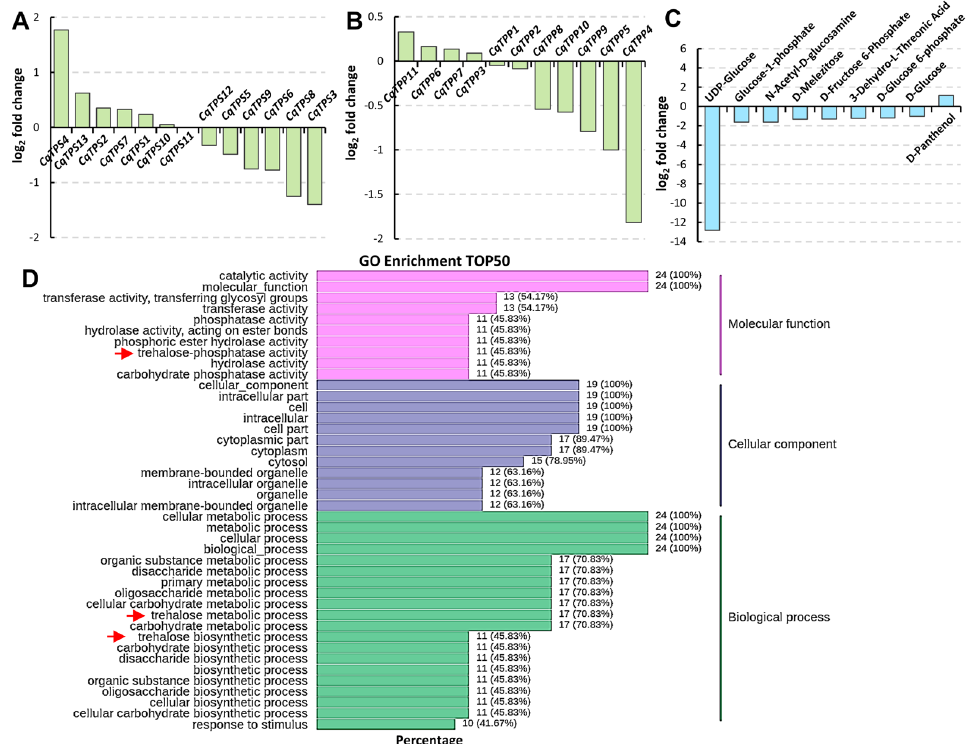
Figure 4. Transcriptome analysis of CqTPSs and CqTPPs and related processes and metabolism analysis of related metabolites in quinoa leaves undergoing saline-alkali stress. ( A , B ) Transcriptome analysis of expression levels of CqTPS and CqTPP family genes in quinoa leaves. Two-week-old quinoa seedlings were treated with a carbonate solution containing 100 mM Na 2 CO 3 :NaHCO 3 = 1:9 for two weeks. ( C ) Metabolism analysis of the differently accumulated metabolites (DAMs) in the starch and sucrose metabolism pathway. ( D ) Go enrichment analysis of total differently expressed genes (DEGs). Arrows, trehalose-related processes.